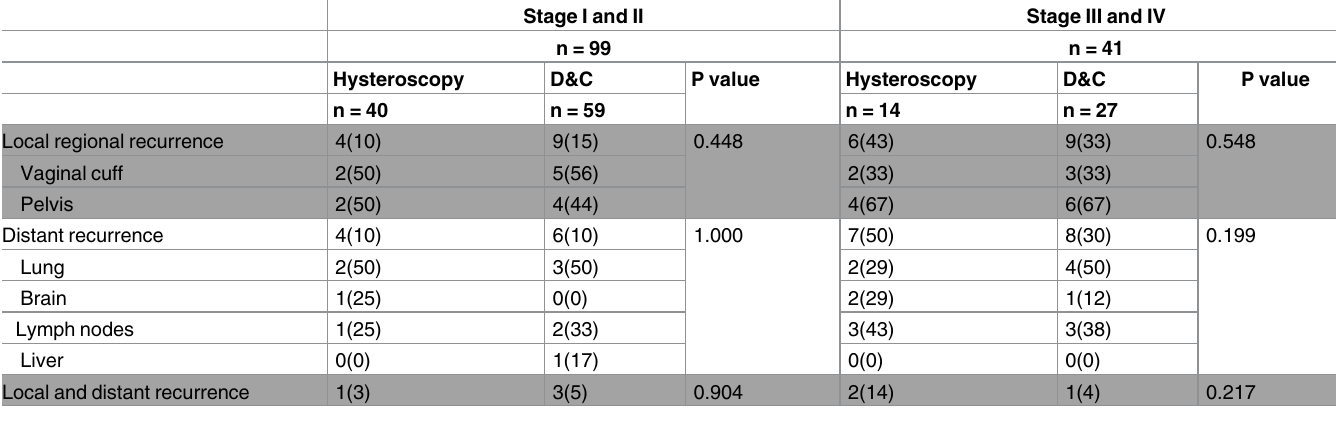
Table 2. Recurrencepatterns between